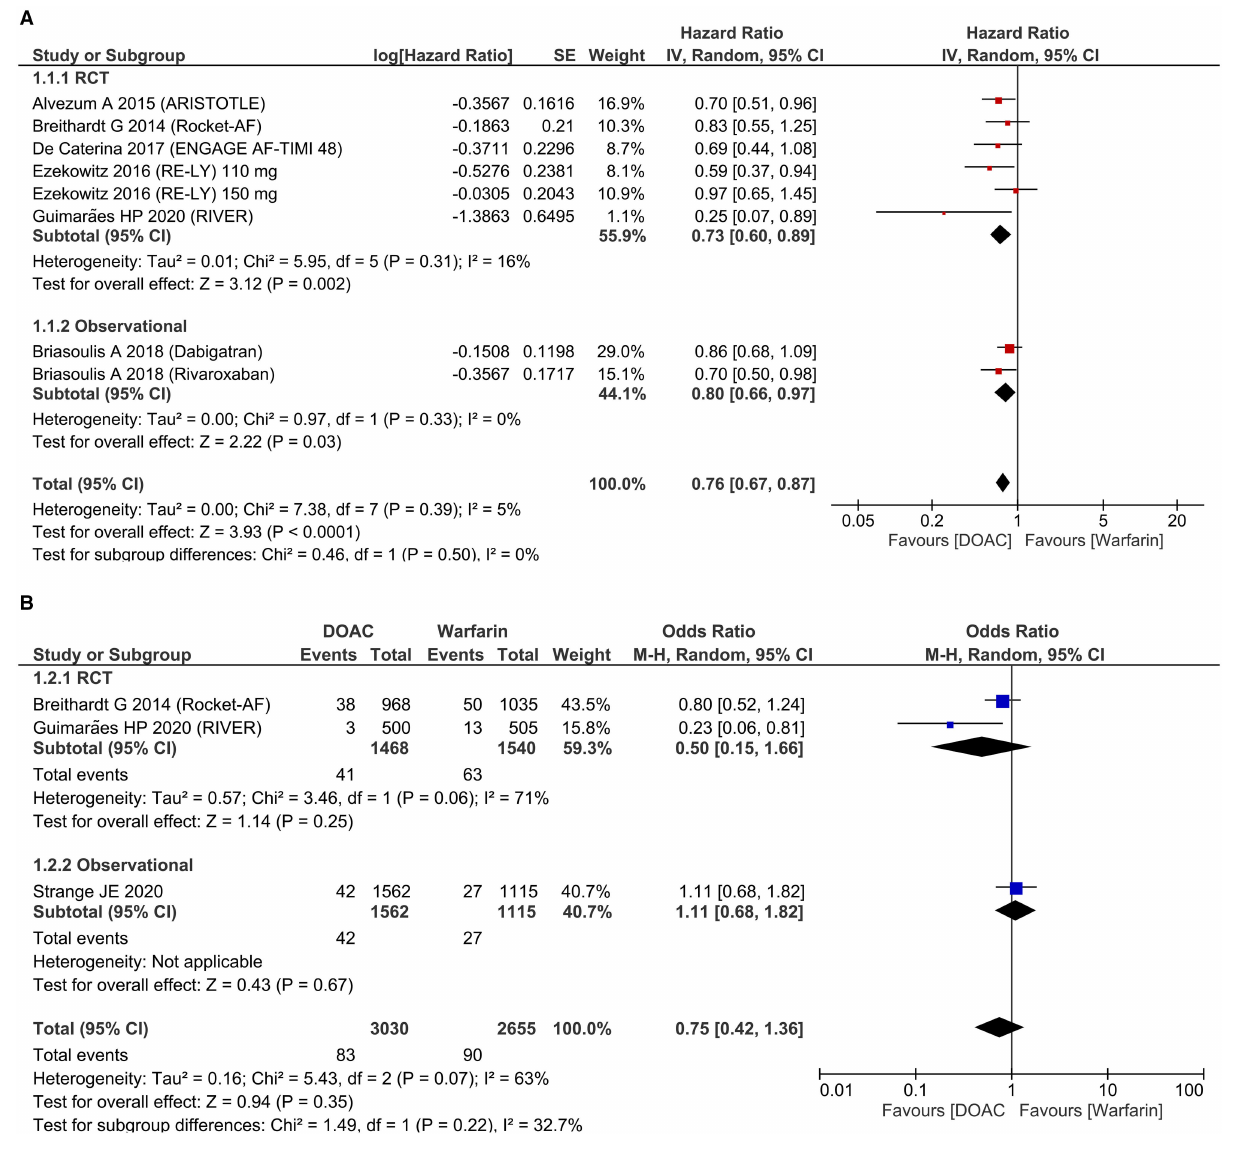
FIGURE 2 | Systemic embolism and stroke. Pooled hazard ratio (A) and dichotomous outcome (B)